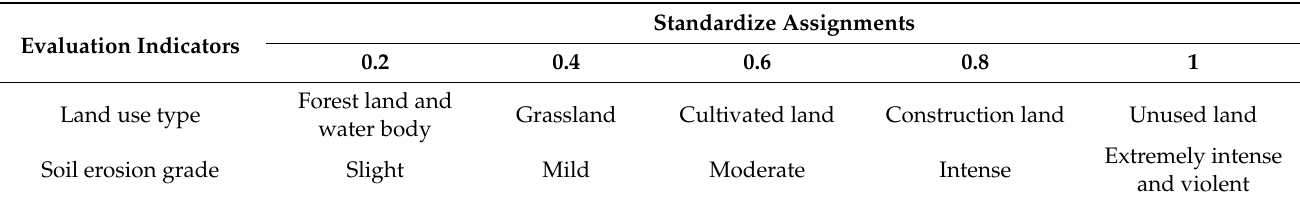
Table 3. Criteria for grading and assigning values to qualitative